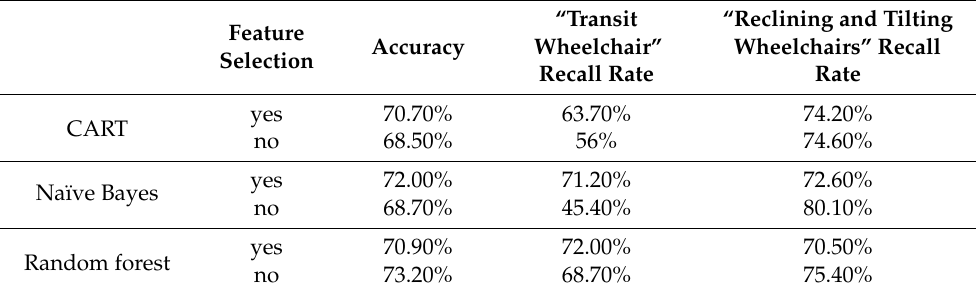
Table 2. Performance comparison of three